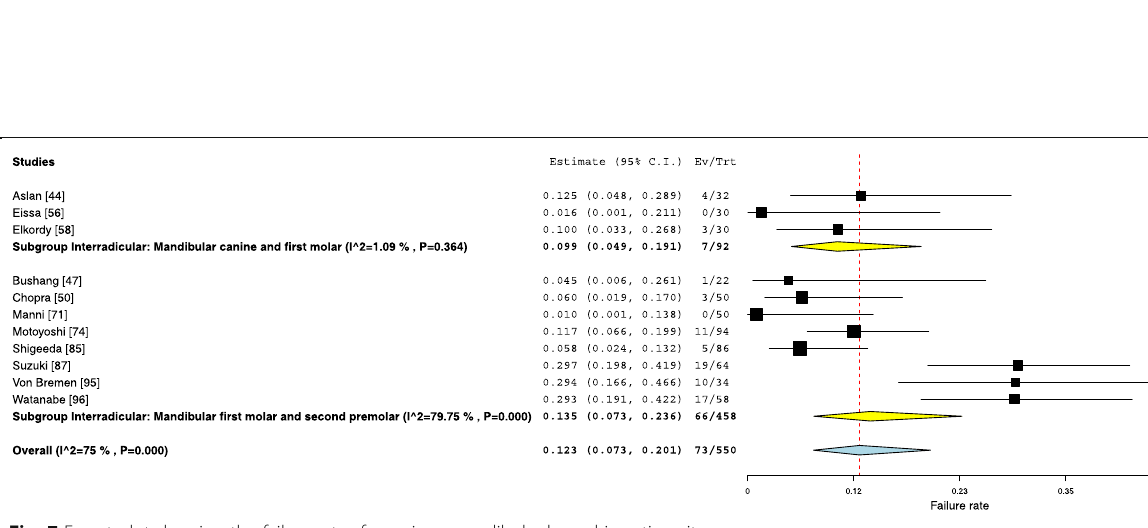
Fig. 7 Forest plot showing the failure rates for various mandibular buccal insertion